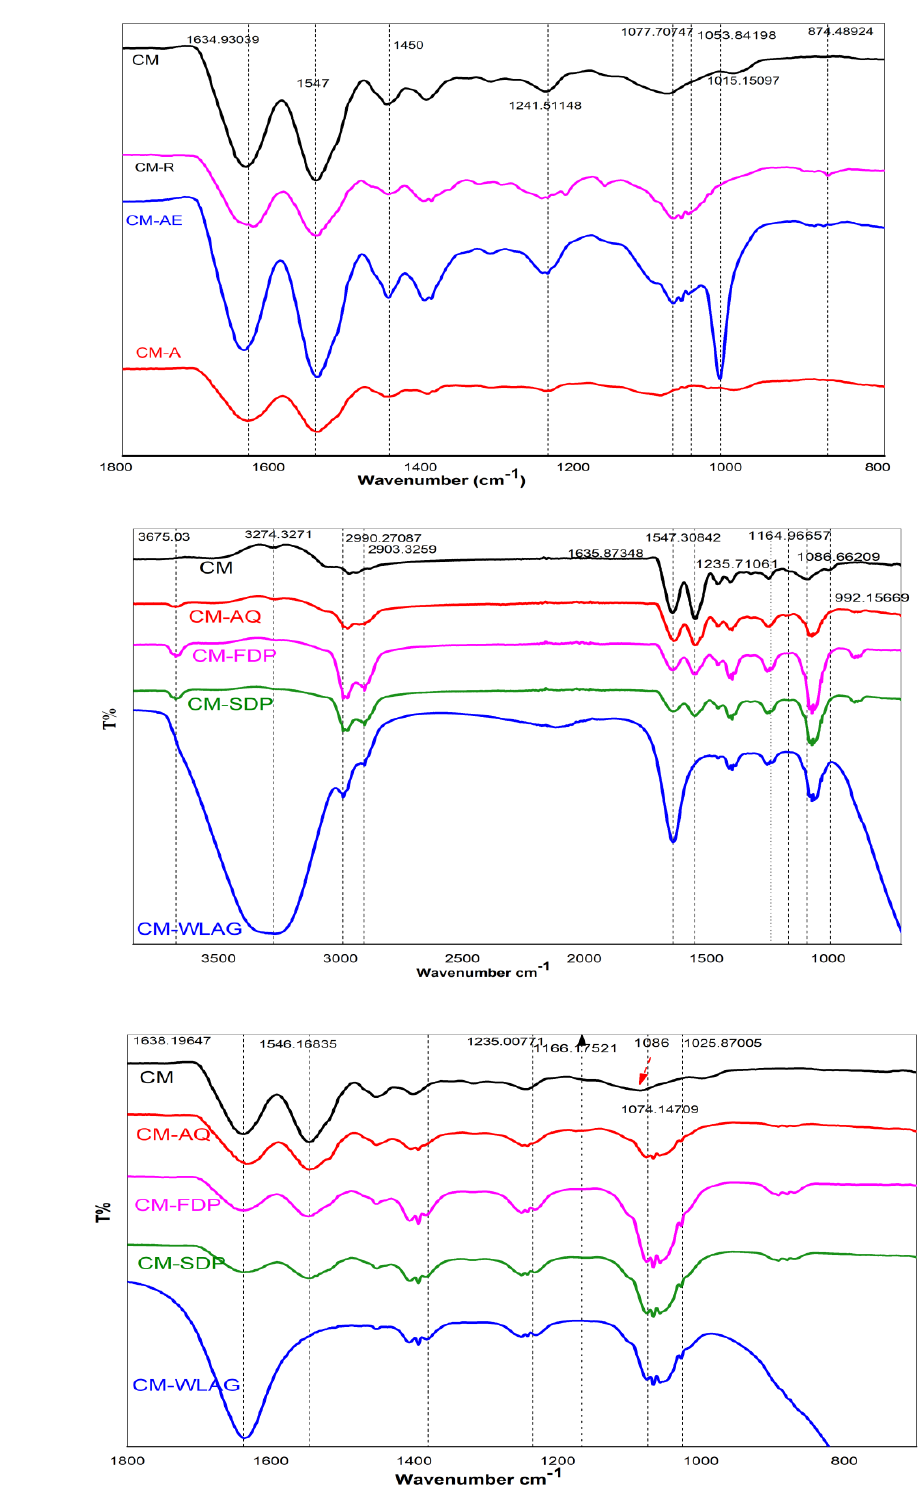
Figure 4. FTIR spectra of aloin (aloin), aloe–emodin (AE), rhein (R), Aloe vera extracted an- thraquinones powder (AQ), spray–dried (SDP) and freeze-dried (FDP) powders of Aloe vera {( A ) (3800–800 cm –1 ), ( a ) (1600–800 cm –1 )}, controlled Casein micelles (CM) individual and its nanocap- sules with pure compounds of aloin (CMA), aloe–emodin (CMAE), rhein (CMR) {( B ) (3800–800 cm –1 ), ( b ) (1800–800 cm –1 )}, Controlled casein micelles individual (CM) and its nanocapsules with various Aloe-vera powders (CMAQ, CMFDP, CMSDP, CMWLAG) {( C ) (3800–800 cm –1 ), ( c ) (1800–800 cm –1